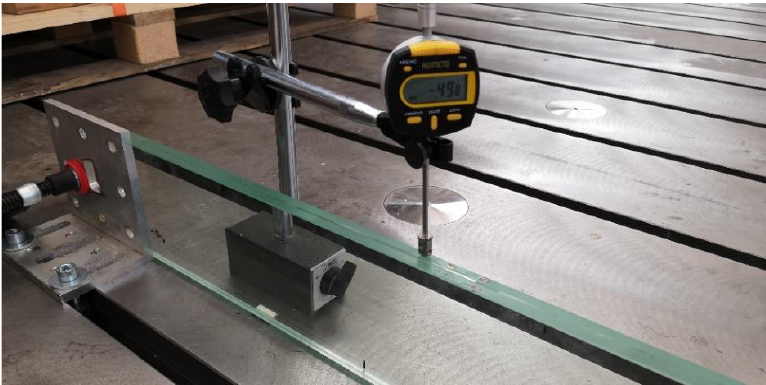
Fig. 5 Measuring the offset with a dial